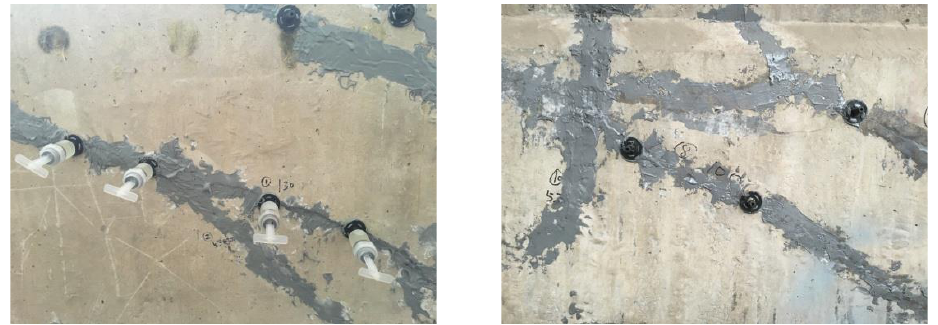
Figure 3. Repair of concrete cracks by filling epoxy paste.